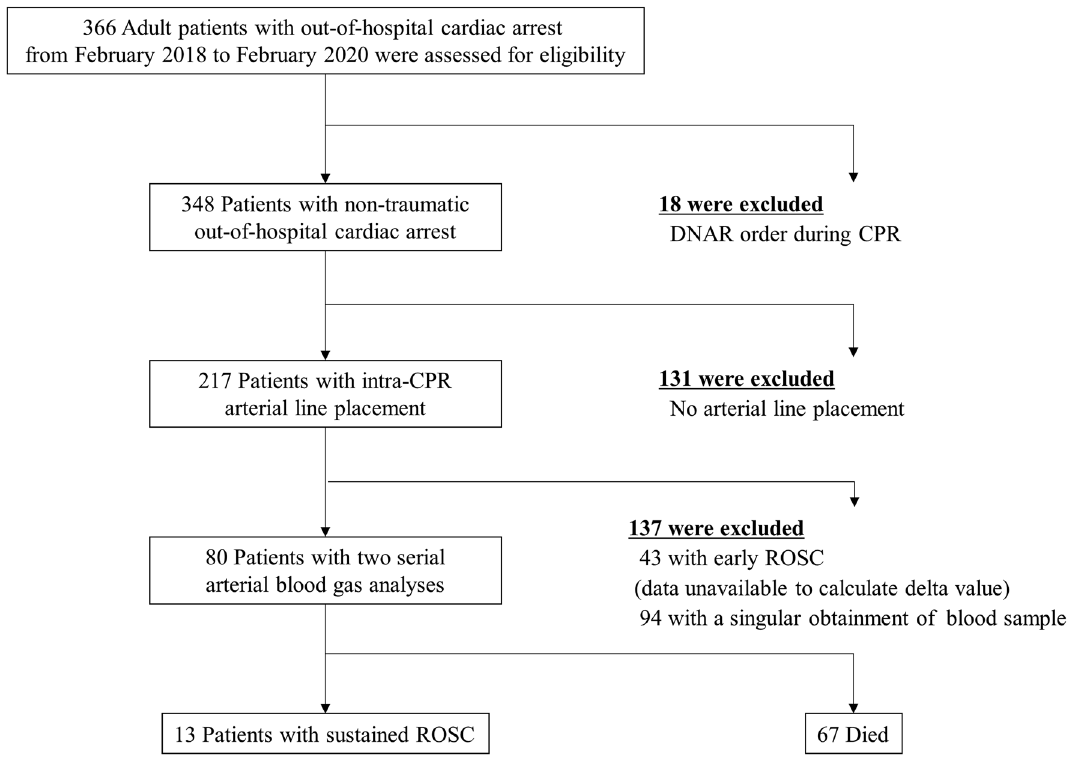
Figure 1. Patient flow chart. To calculate the delta values of ABGA parameters, two serial ABGAs were obtained for each patient included in the study. ABGA arterial blood gas analysis, CPR cardiopulmonary resuscitation, DNAR do not attempt resuscitation, ROSC return of spontaneous